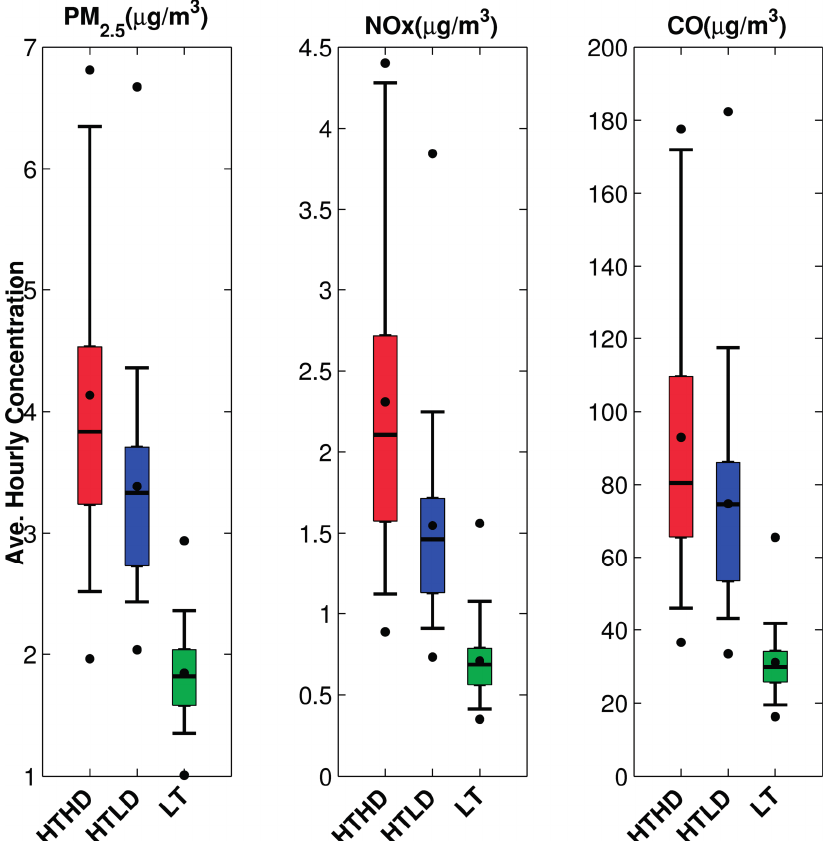
Figure 7. Average hourly pollutant concentrations for PM 2010 period, separated into high-traffic, high-diesel (HTHD), high-traffic, low-diesel (HTLD), and low-traffic (LT)